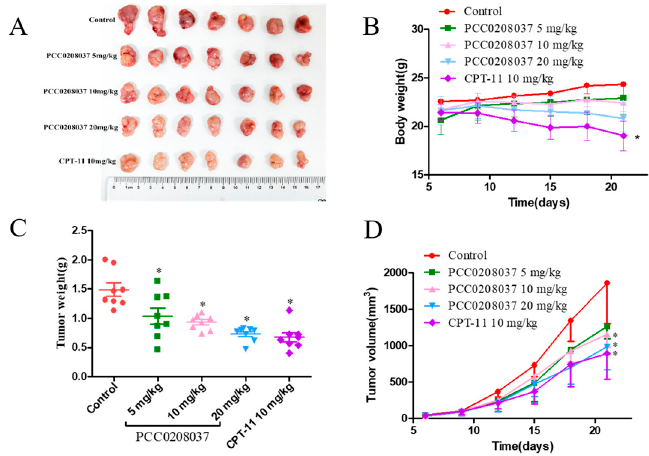
Figure 8. Anti-tumor effect of PCC0208037 in the LS180 xenograft tumor model. ( A ) Representative tumors removed after the last treatment in each treatment group. ( B ) Body weight gain curves of mice bearing an LS180 xenograft tumor. ( C ) Tumor weights in the different groups of mice after 15 d of treatment. ( D ) Tumor growth curves in mice that received PCC0208037 or CPT-11 treatment. * p < 0.05 as compared to the control.